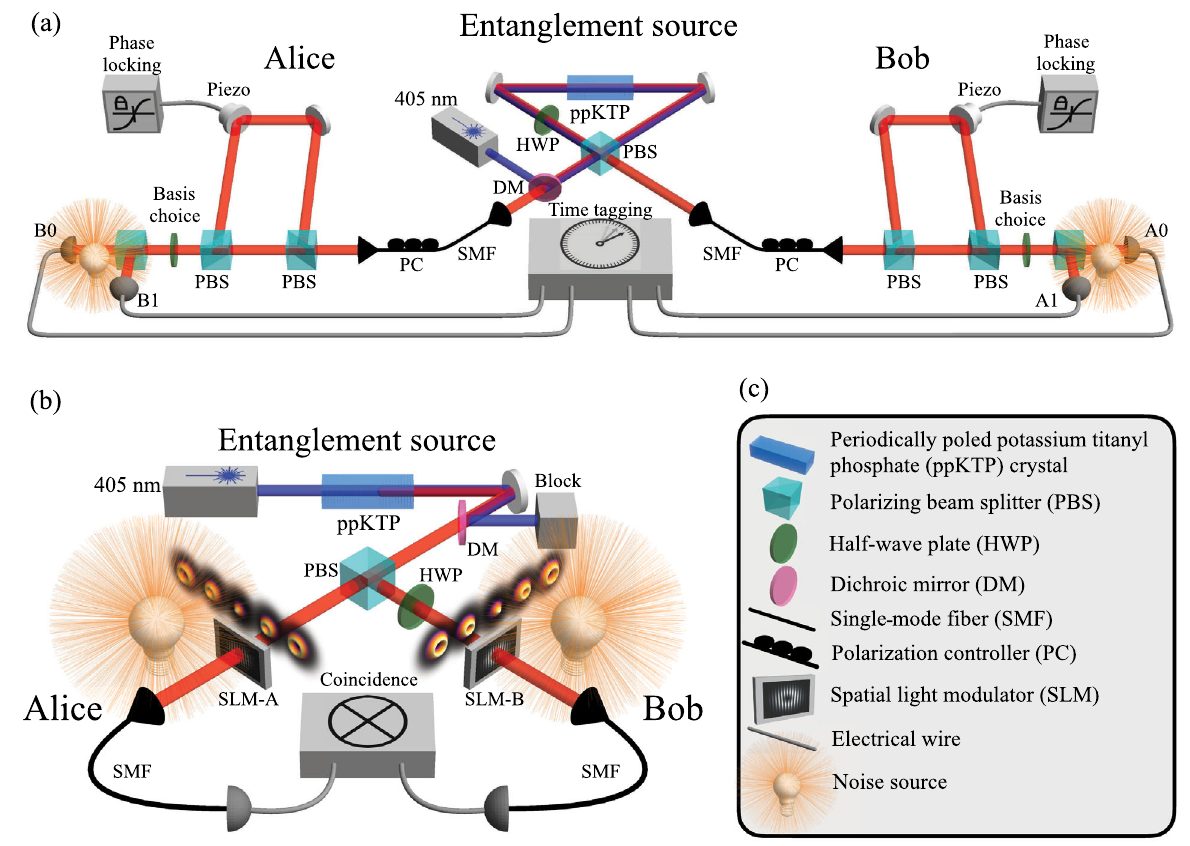
FIG. 2. Experimental setup for (a) energy-time and (b) orbital angular momentum (OAM) d.o.f. In both experiments, a 405-nm continuous-wave laser produces high-dimensionally entangled photon pairs in a ppKTP crystal exploiting type-II spontaneous parametric down-conversion (SPDC). The noise is optically added by intensity-adjustable light sources and single-photon detection is accomplished using avalanche photodiodes. (a) Additional polarization entanglement is generated by bidirectionally pumping the crystal in a polarization Sagnac interferometer. The polarization basis the photon pairs are measured in after an actively stabilized postselection-free Franson interferometer defines the measurement basis in the time domain. Each detection event is time tagged and recorded by means of a time-to-amplitude converter. (b) The OAM-entangled pairs are split depending on their polarization, analyzed through mode filtering by modulating the complex amplitude of the photons, and subsequently coupled into SMFs. Coincidence counts are recorded using a coincidence